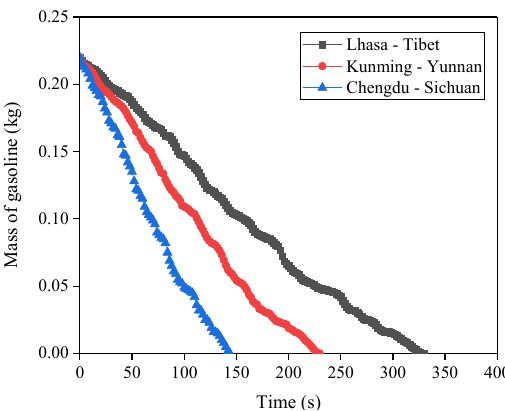
Figure 3. Mass variation of gasoline during the burning process.